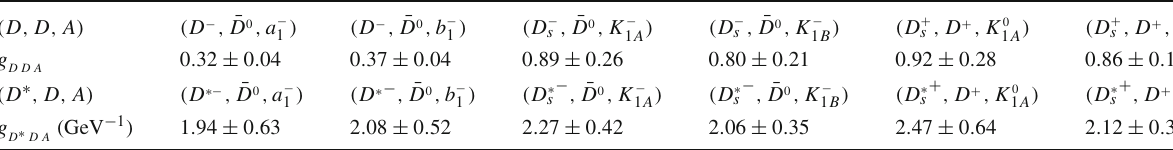
, K − , D − , D − ,χ ) and s 1 1 1 1 A c 1